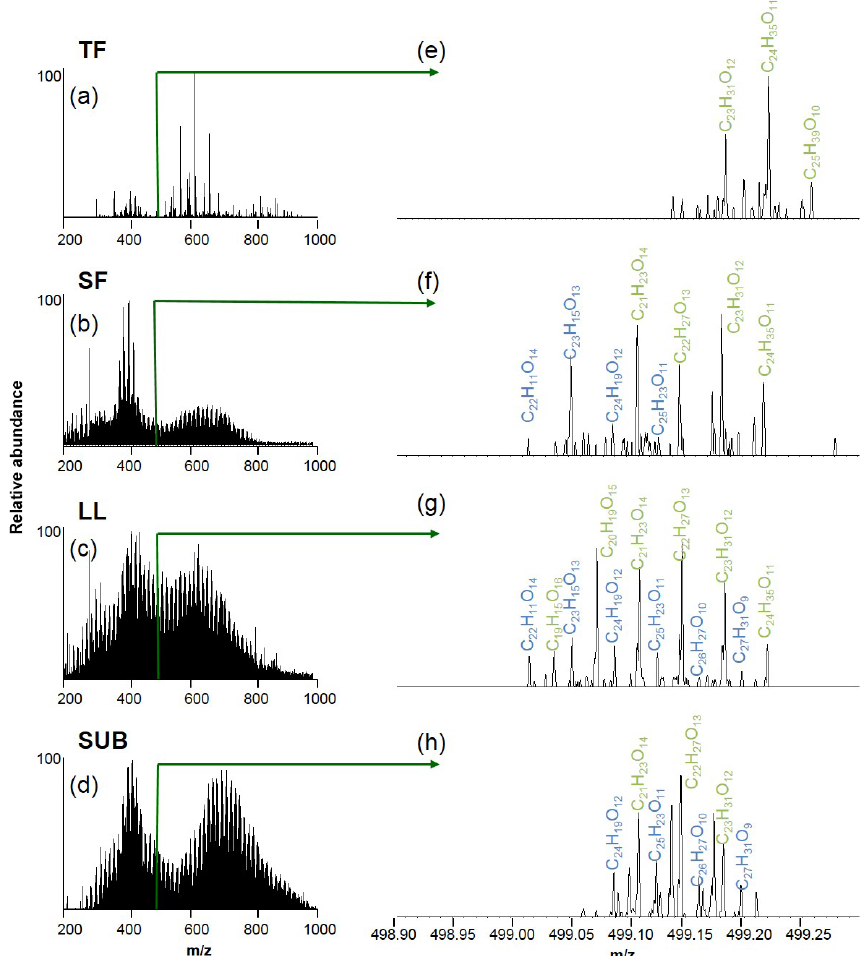
Figure 4. Raw electrospray ionization Fourier transformation ion cyclotron resonance mass spectra (ESI FT-ICR-MS) of unmanaged beech forest samples from the Schorfheide (a–d) and details for m/z 499 (e–h) . Assigned molecular formulae are in green and blue. TF: throughfall; SF: stemflow; LL: litter leachate; SUB: subsoil